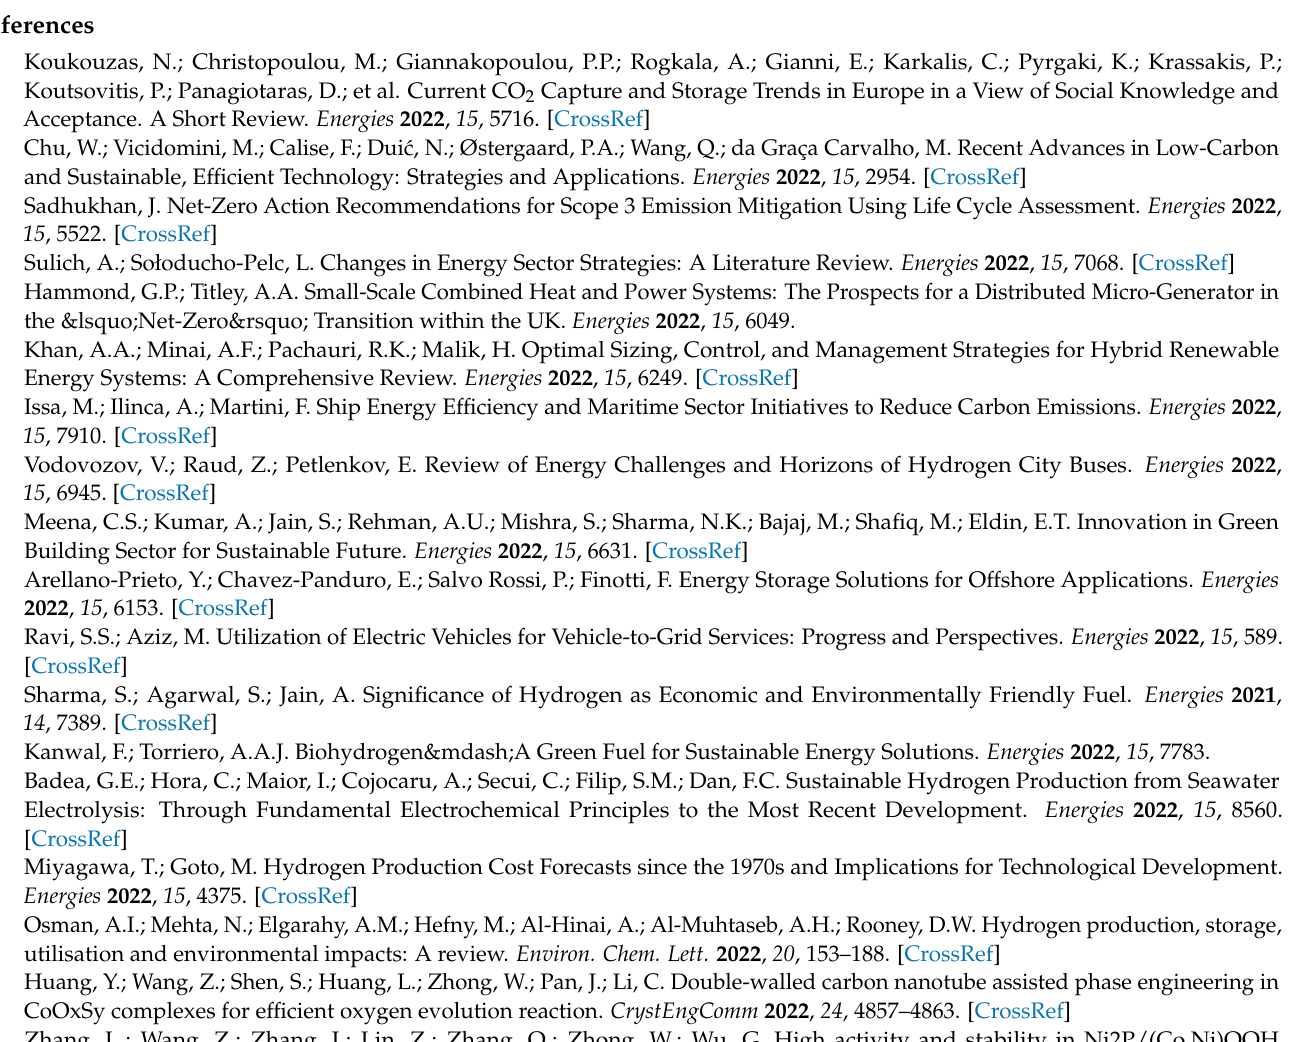
Figure A3. Optical microscope images and particle size distributions for solid residuals remaining after reaction of different composite samples: ( a ) scrap and 50–100 nm copper powder; ( b ) scrap and 1–19 μ m copper powder; ( c ) scrap and 50–70 μ m copper powder; ( d ) scrap and 150–250 μ m copper powder; ( e ) scrap ball milled without additives (copper contained in D16 aluminum alloy).